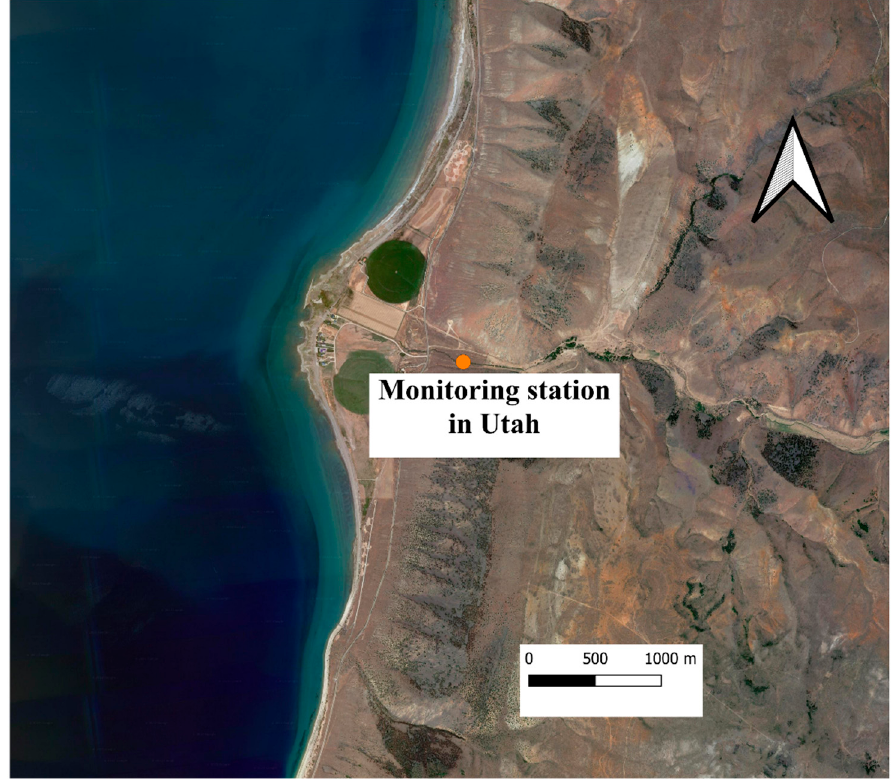
Figure 5. Sample monitoring station used in the current study.